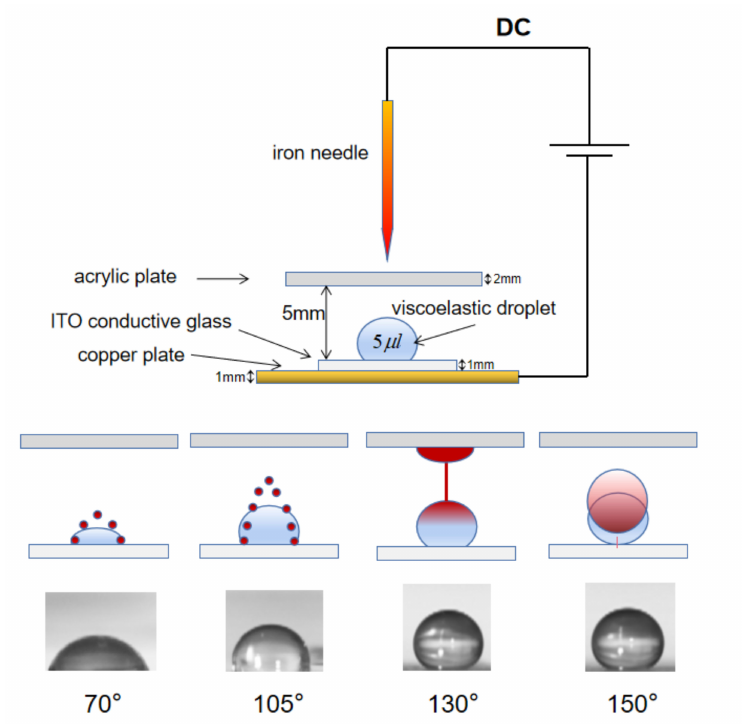
Figure 1. Deformation of viscoelastic droplets between a needle-plate electrode system. The electrodes are composed by an iron needle and a copper plate, and the acrylic plate is used as a platform to receive the corona discharge, and is polarized to generate an electric field, making the ITO glass conduct electricity and droplets on it deform. Behaviors of droplets for different contact angles of 70, 105, 130, and 150 degrees. The droplet deformation reaches an equilibrium for contact angles of 70 and 105 degrees, whereas for 130 degrees the droplet is stretched to the top acrylic plate, forming a liquid bridge a thin filament in the middle. For 150 degrees, the droplet can take off toward the top acrylic